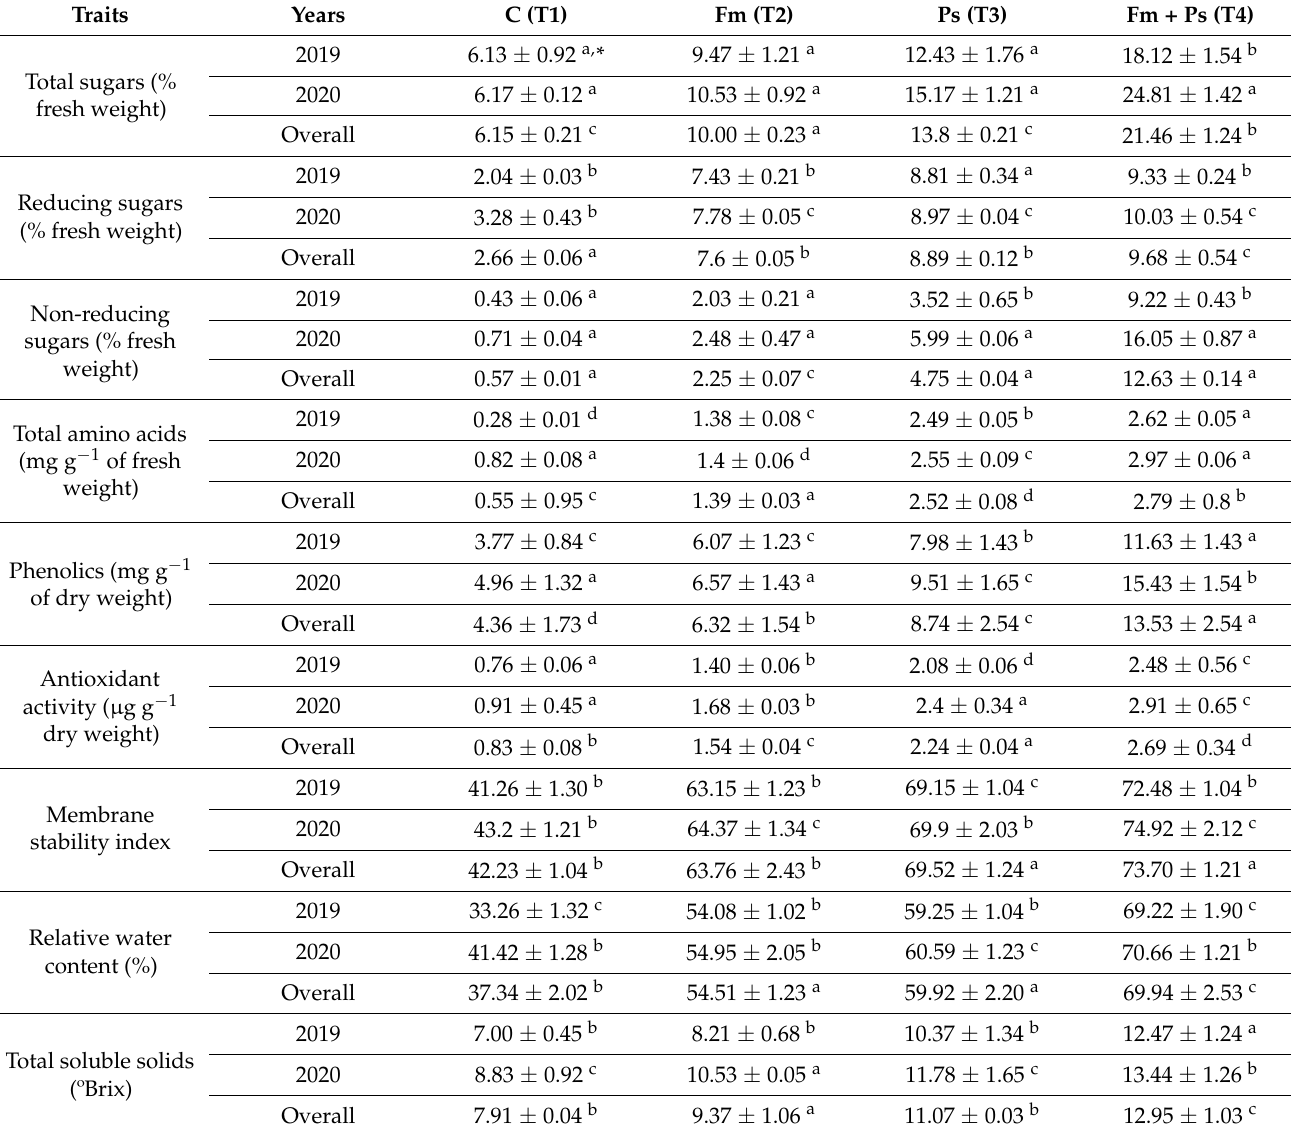
Table 2. Effects of Funneliformis mosseae and potassium silicate application on biochemical traits of onion under water